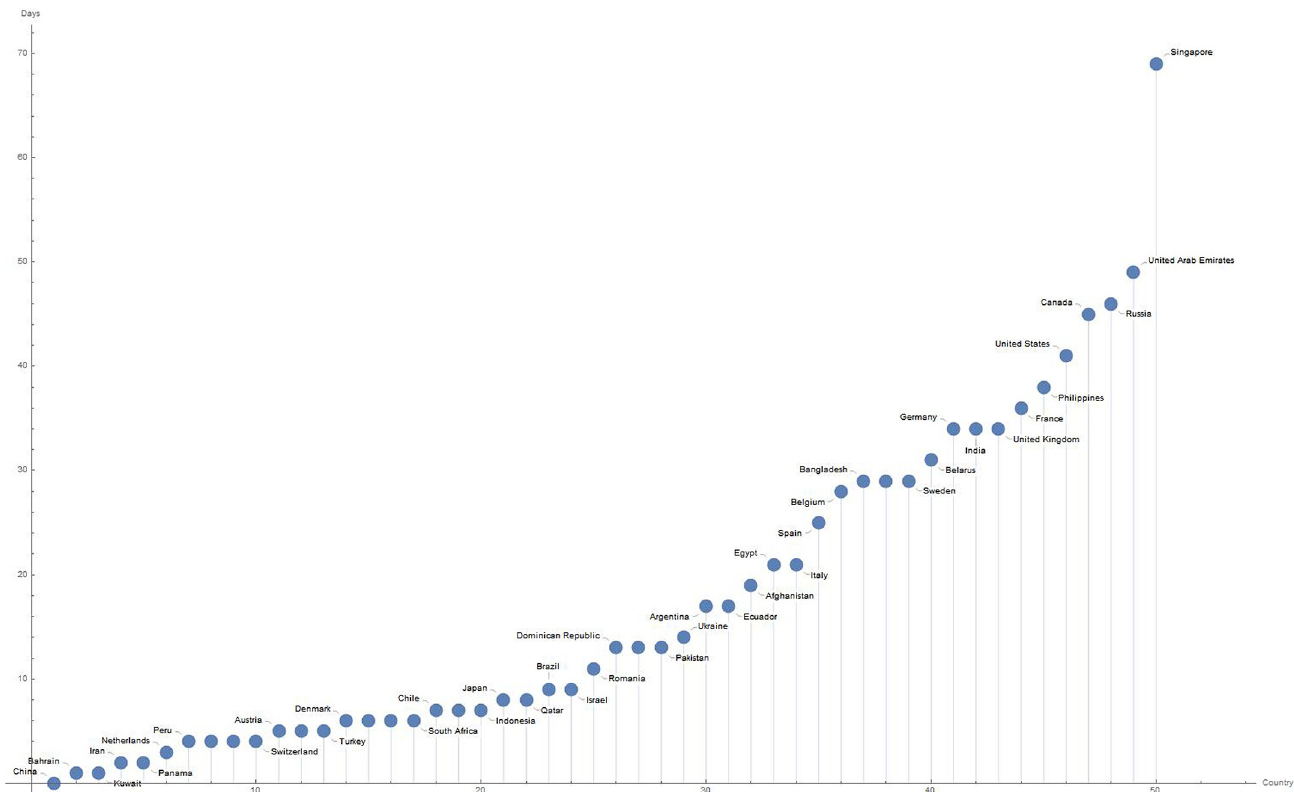
Fig 7. Latency times for 50 countries with more than 10000 recorded case. The plot displays the countries on the x-axis and the days of latency on the y-axis, considering as starting day, January 22,